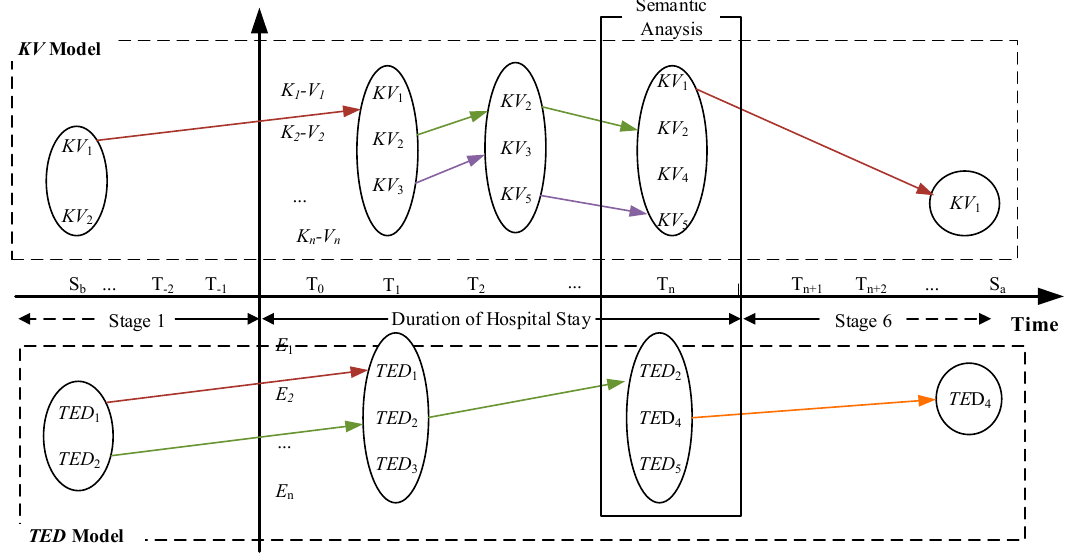
Figure 2. Overview of TDM-PC.